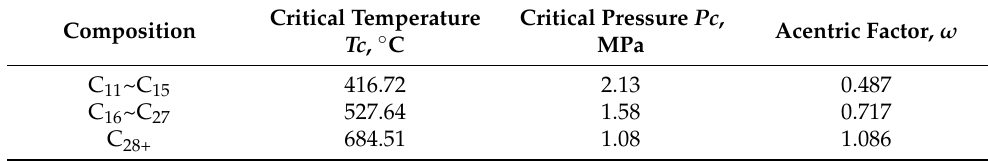
Table 5. Corrected critical temperature, critical pressure, and acentric